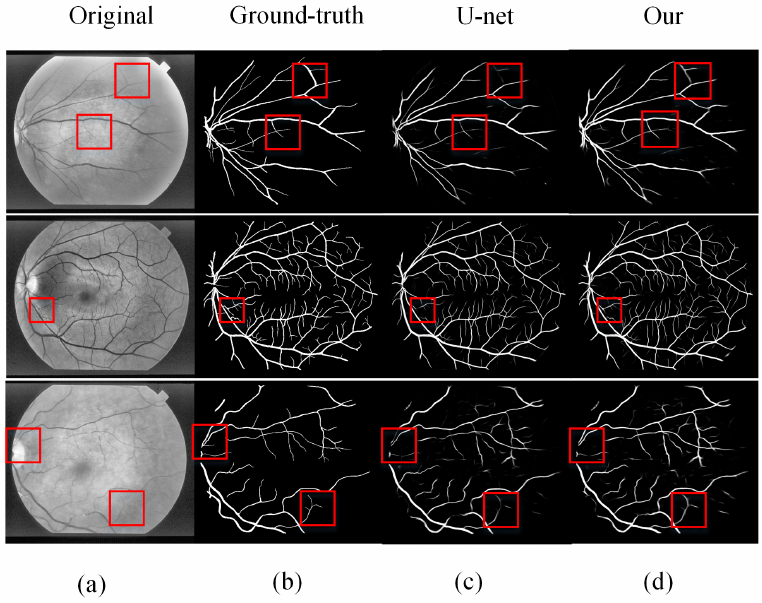
Figure 11. Comparison of STARE segmentation results: ( a ) original image, ( b ) ground-truth, ( c ) U-Net segmentation results, and ( d ) MRU-Net segmentation results.